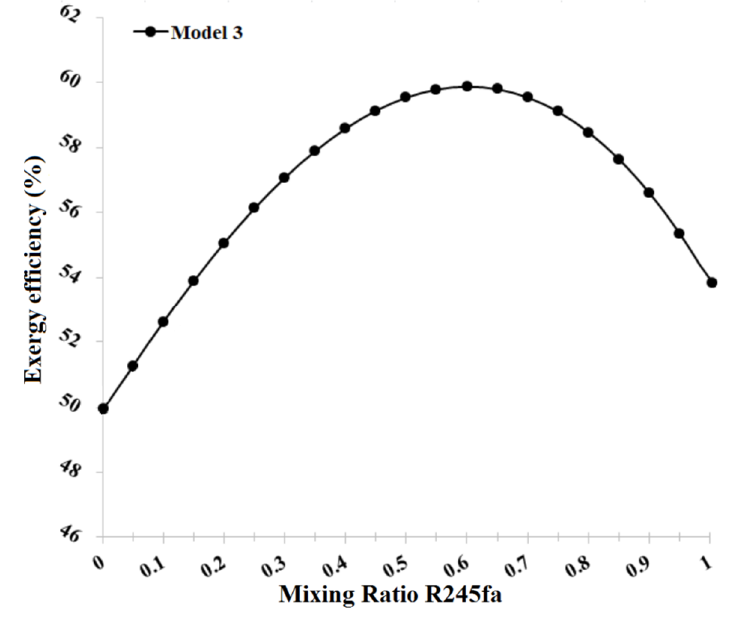
Figure 7. The exergy e ffi ciency of model 3 as a function of working fluid mixing ratio.